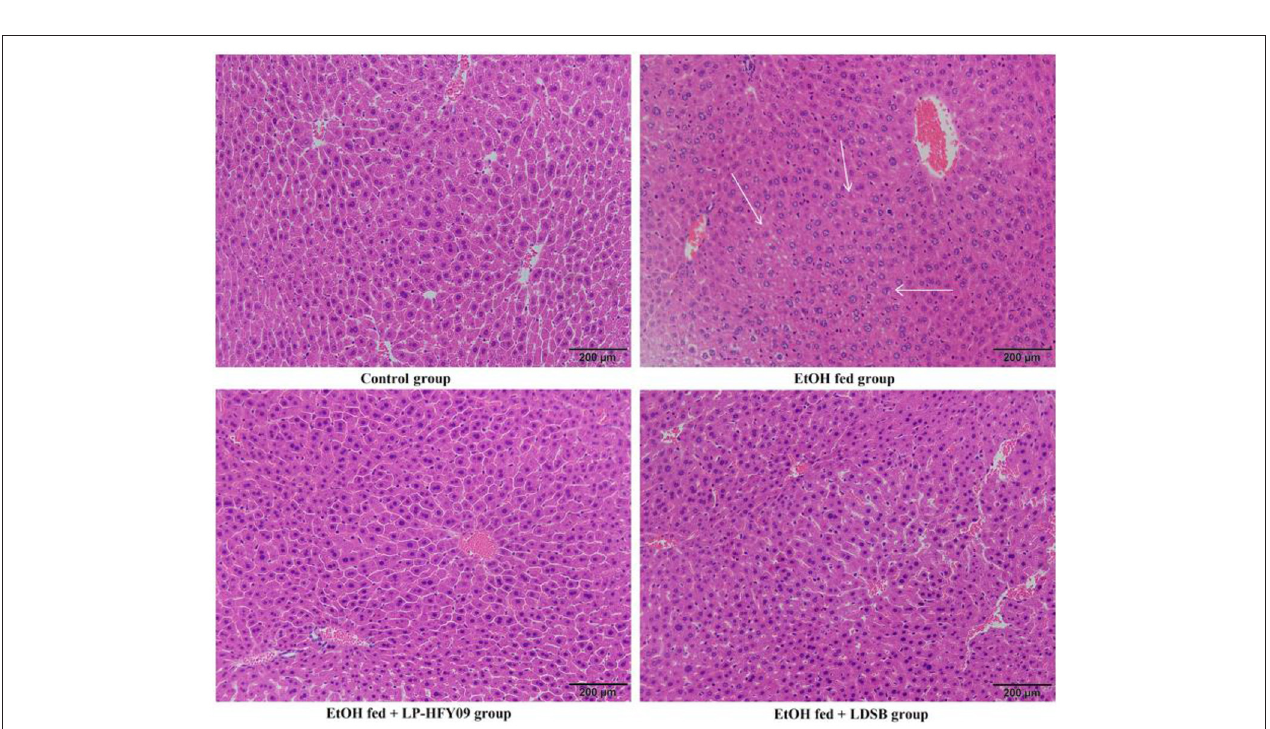
FIGURE 3 | Hematoxylin-eocin (H&E) pathological observation of liver in mice. Magnification 100 × . Control, mice without treatment; EtOH fed, mice treated with 56 ◦ ethanol of 0.13 ml/10g bw; EtOH fed + LDSB, mice treated with 1.0 × 10 9 CFU/kg of Lactobacillus delbruechill subsp. bulgaricus before ethanol-treatment; EtOH fed + LP-HFY09, mice treated with 1.0 × 10 9 CFU/kg of Lactobacillus plantarum HFY09 before ethanol-treatment.